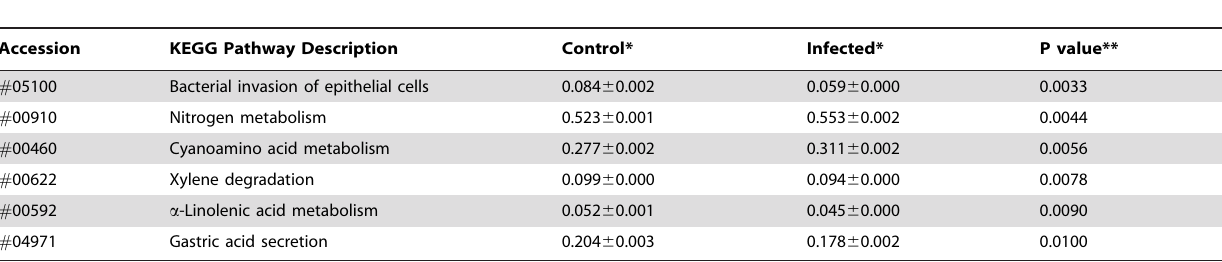
Table 4. KEGG pathways impacted by Ostertagia ostertagi infection in immune